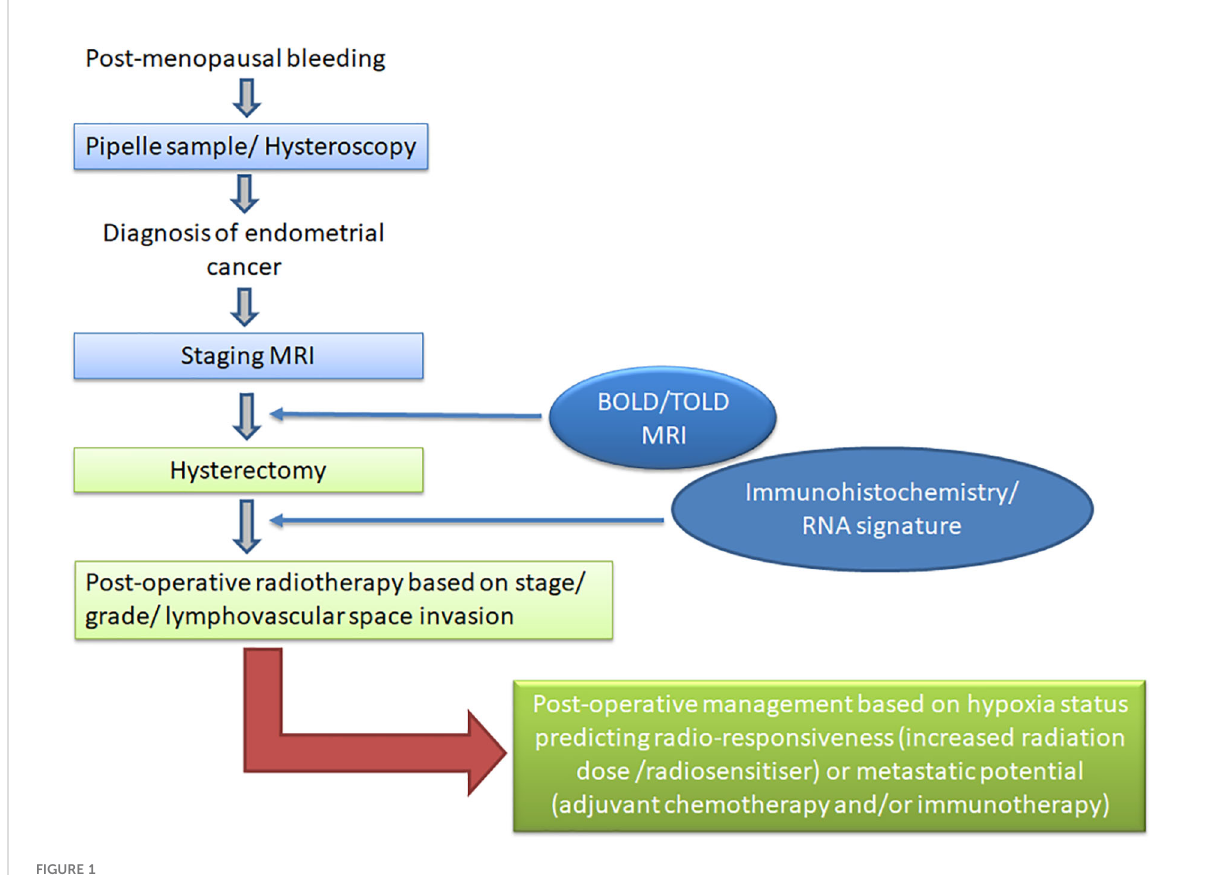
FIGURE 1 Diagnostic and management pathway for patients with endometrial cancer. Current diagnostic tests are shown in light blue and proposed hypoxia imaging in dark blue; current management options are shown in light green and alternative strategies based on hypoxia imaging and molecular strati fi cation in dark